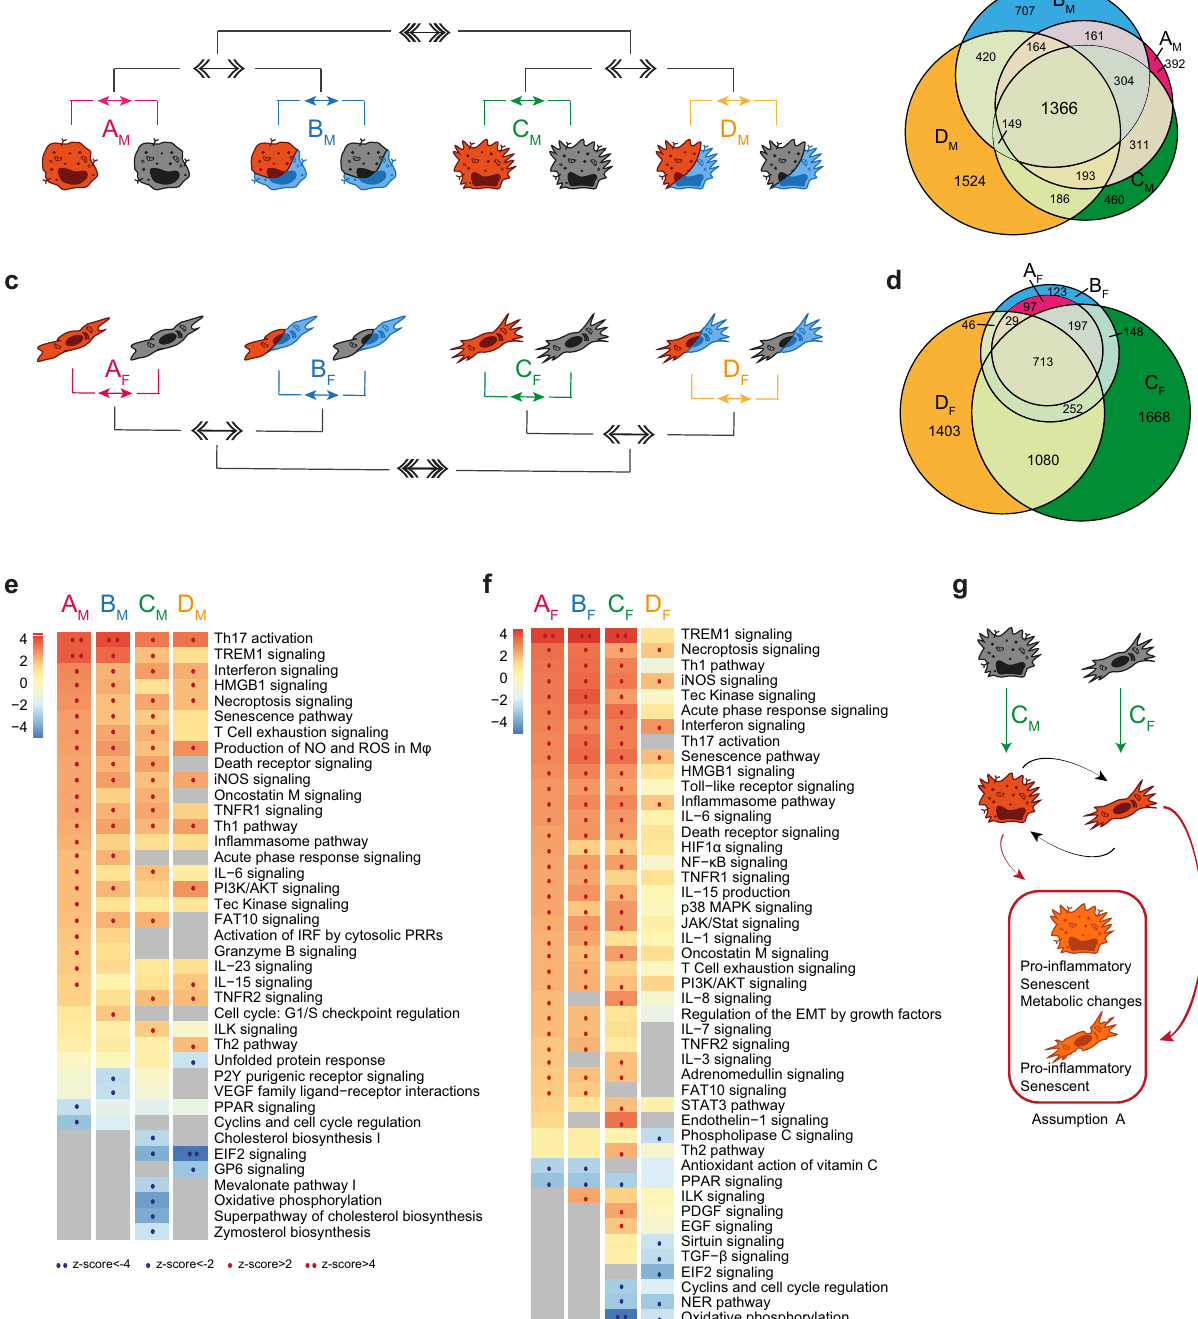
DEGs in each 1st level comparison in M φ ( b ) and Fb ( d ). e , f Pathways enrichment analysis in M φ ( e ) and Fb ( f ) comparisons. Columns represent 1st level of com- parisons (A-B-C-D), rows report pathways signi fi cantly modulated (|z-score| ≥ 2) in atleastonecomparison.Colorintensitybarindicatesthelevelofpositive(inred)or negative (in blue) enrichment; dots appear only when pathways are signi fi cantly enriched; gray indicates no modulation. See also Fig. S2. g Schematic representa- tion of cellular changes in the key condition which feeds assumption A in the mathematical model. Source data of heatmaps e , f are provided as a Source Data fi